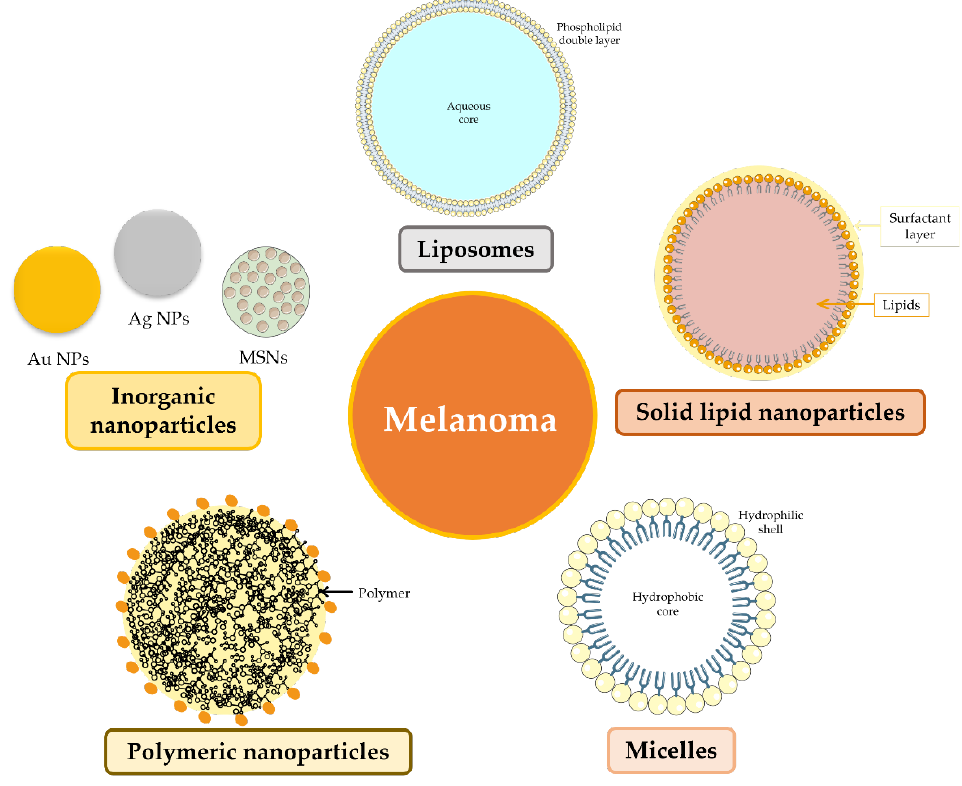
Figure 3. Drug delivery systems used in melanoma therapy. Table 1. Summary of various flavonoids in the management of melanoma loaded in different nanosystems.